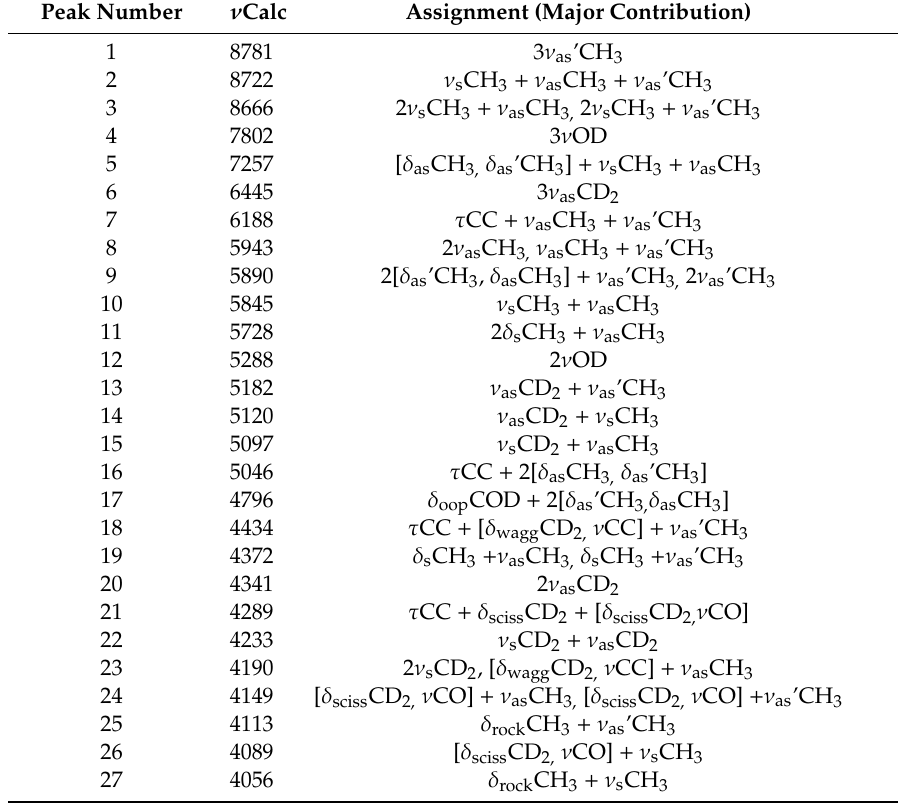
Band assignments in NIR spectra of CH 3 CD 2 OD based on GVPT2 // B2PLYP-GD3BJ / def2-TZVP // CPCM calculations. Band numbering corresponds to that presented Figure 6C.